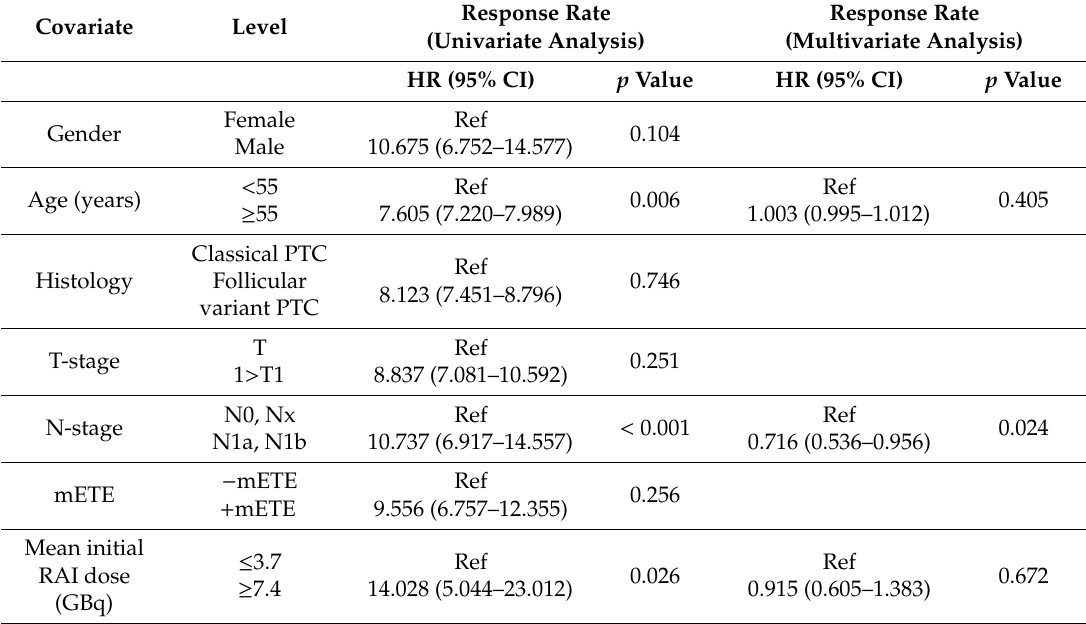
Table 3. Prognostic risk factors for poorer responder rates (uni- / multivariate analysis).